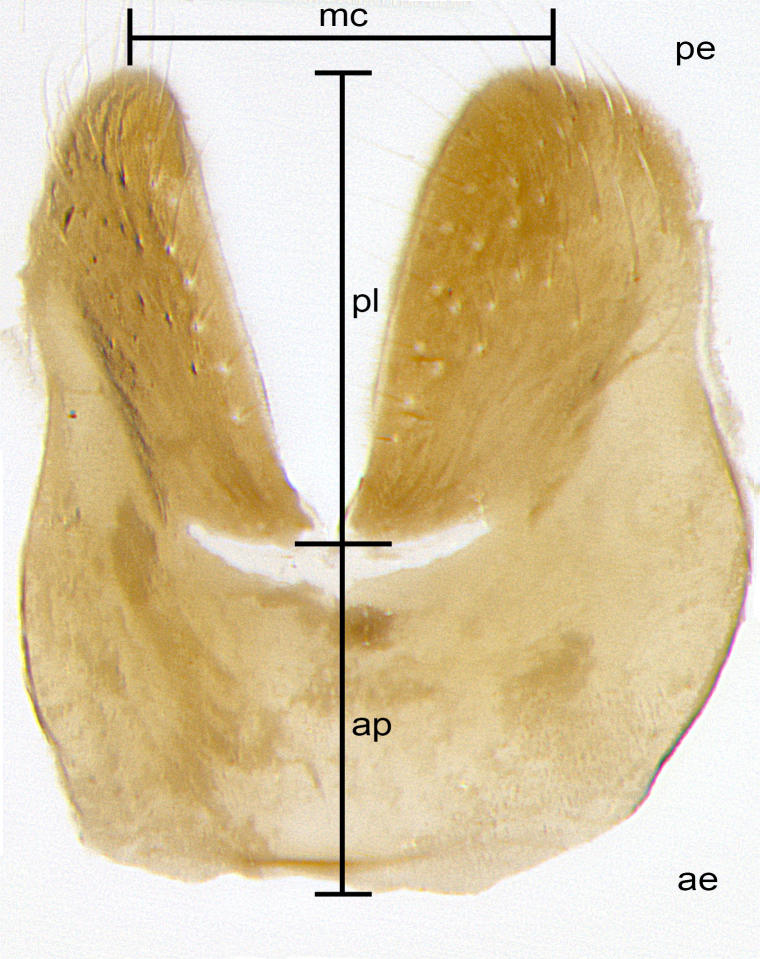
abbreviations: ae = anterior edge; ap = anterior plate; mc = median cleft; pe = posterior edge; pl = posterior lobes.